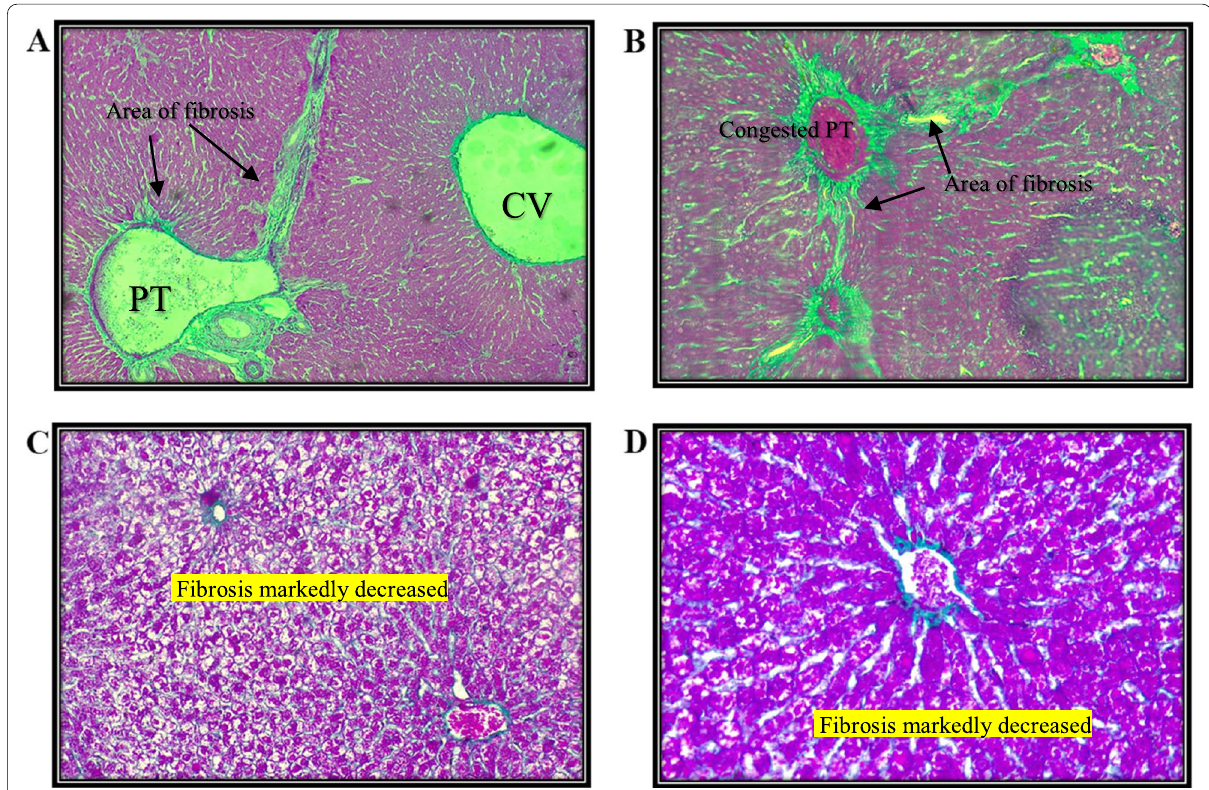
Fig. 4 The liver tissue of pathological control (Masson trichrome stain) showed A , B deposition of collagen fibers around portal area (PT) area and around central vein (cv) with extension to PT. C, D A photomicrograph of a section in BM‑MSC‑treated rat liver showing marked decrease